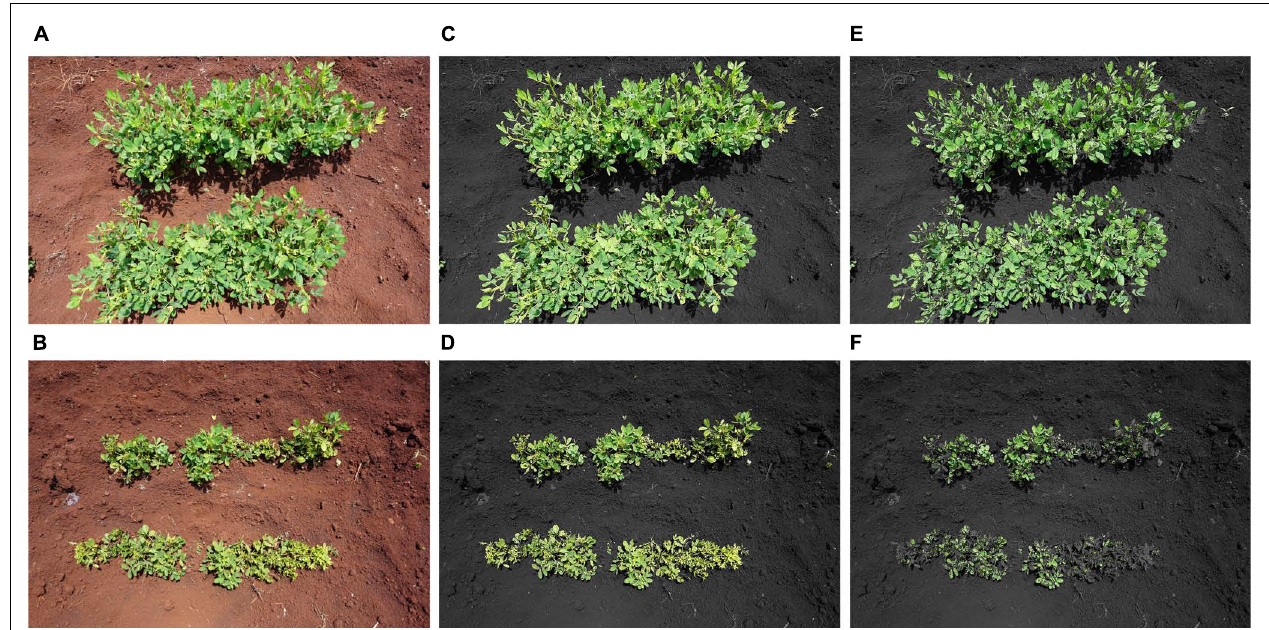
FIGURE 1 | RGB images of groundnut rosette disease resistant (A) and susceptible (B) genotypes taken at 0.8 m above the plant canopy before and after analysis using BreedPix 0.2 option of the maize scanner 1.6. Images A and B show the original images, images (C,D) show the green area (GA), and images (E,F) show the greener area (GGA) with all yellowish (hue angle 60–80 ◦ ) pixels removed.